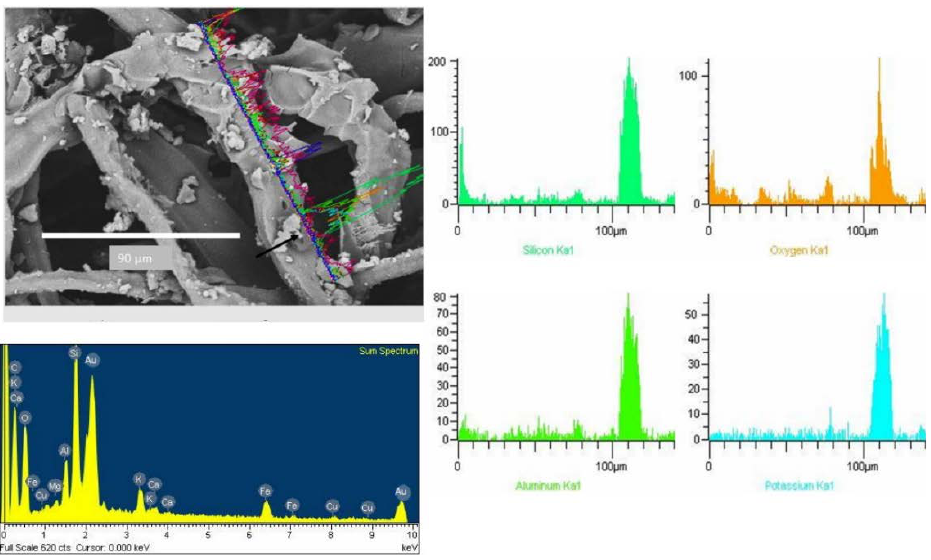
Figure 7. Identification of mineral K-feldspar particles by SEM-EDX (arrow particle <10 µ